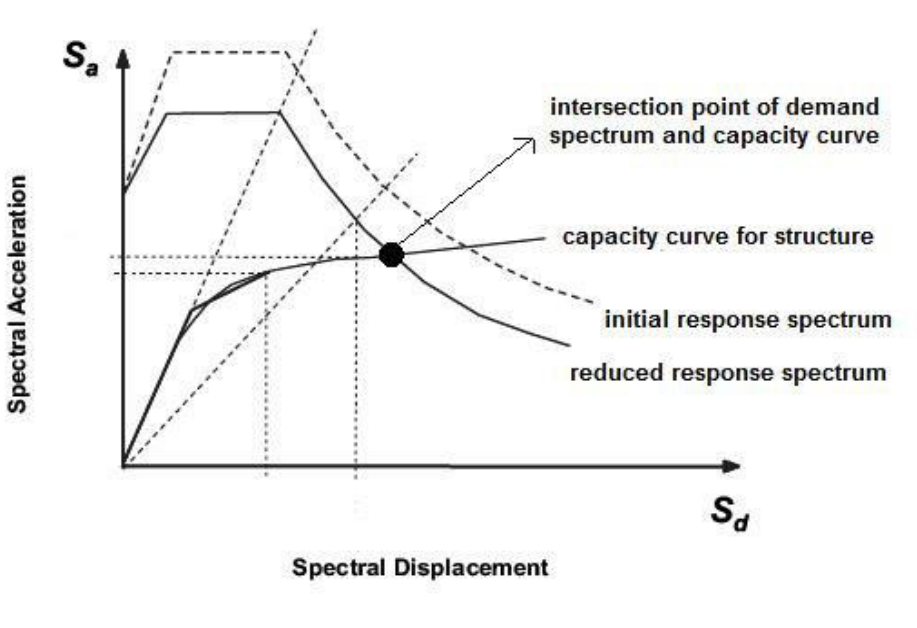
Fig. 5. Target displacement computed by